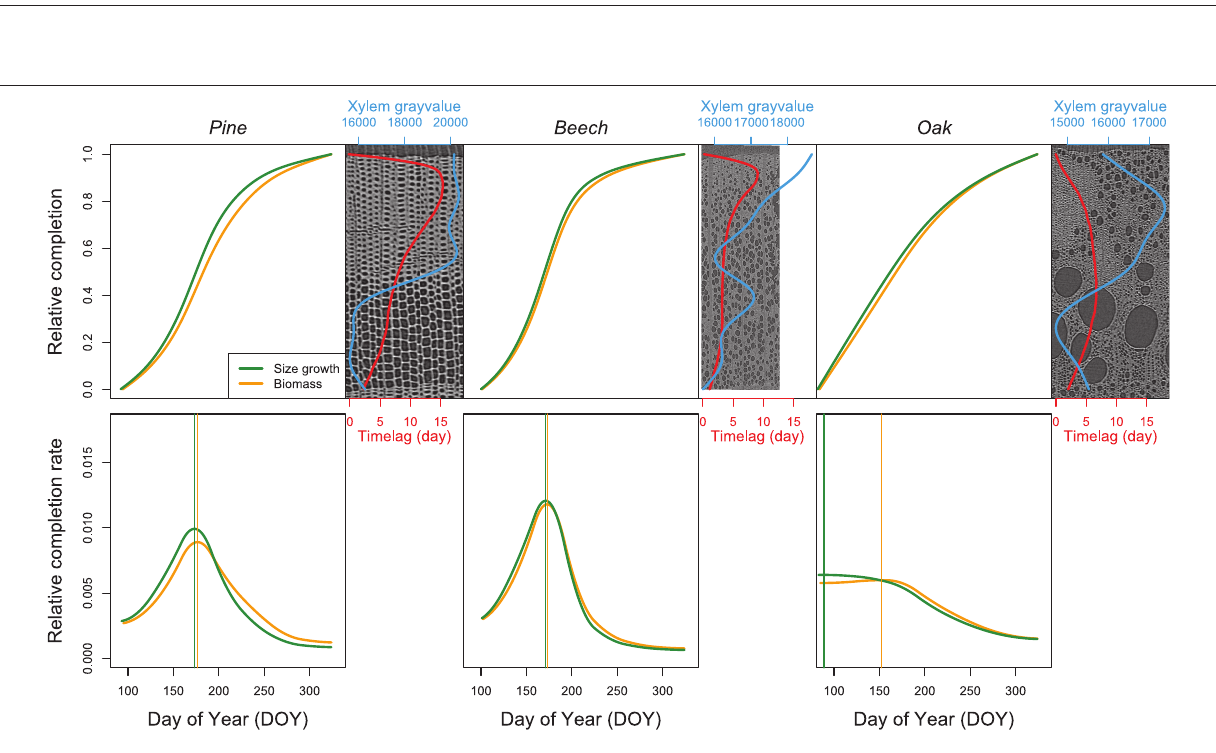
Frontiers in Plant Science |